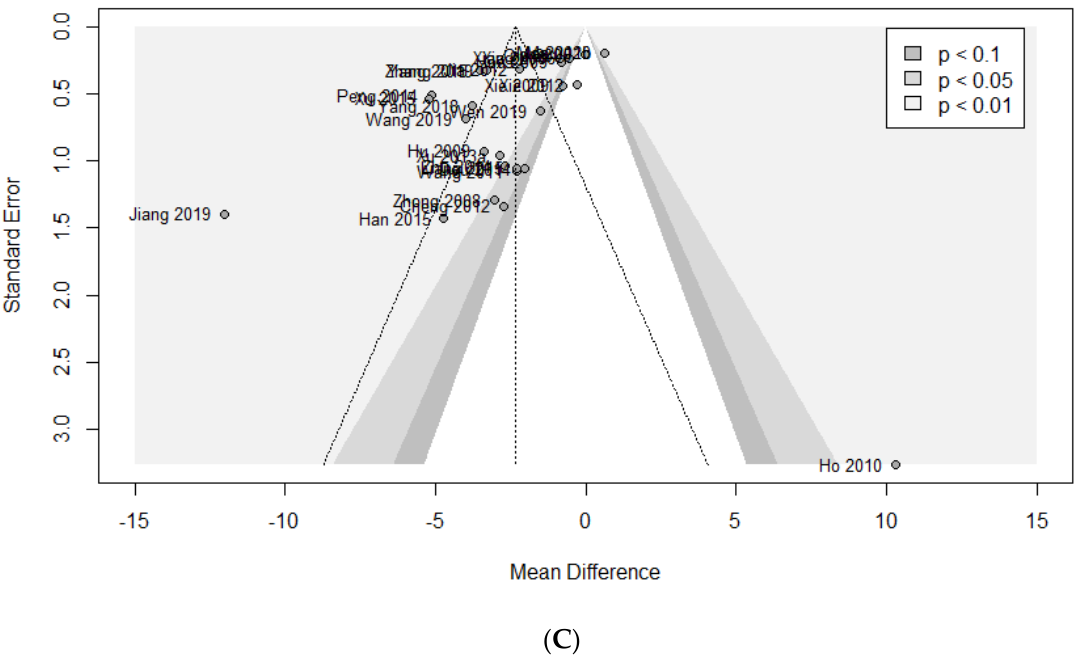
Figure 9. Contour-enhanced funnel plot of the trials for ( A ) PASI 70; ( B ) PASI 60; ( C ) continuous PASI score.